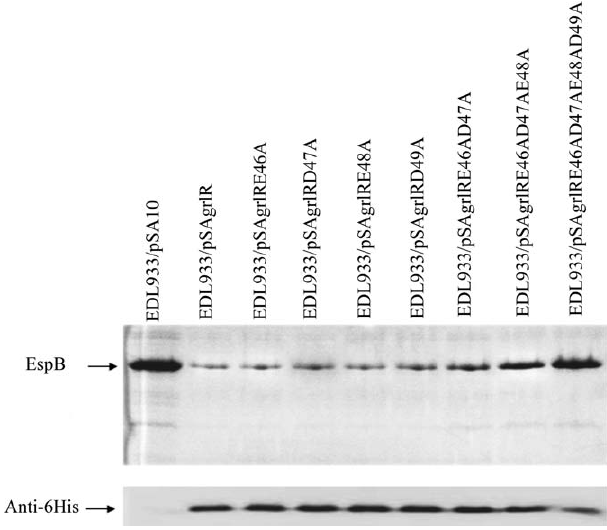
grlR and Expressing Wild-Type and Mutants of GrlR Secreted proteins were concentrated from supernatants of bacterial culture grown in DMEM and resolved in 12% SDS-PAGE and stained with coomassie brilliant blue (upper panel). Western blot of EHEC total cell protein against 6His antibody (lower panel).